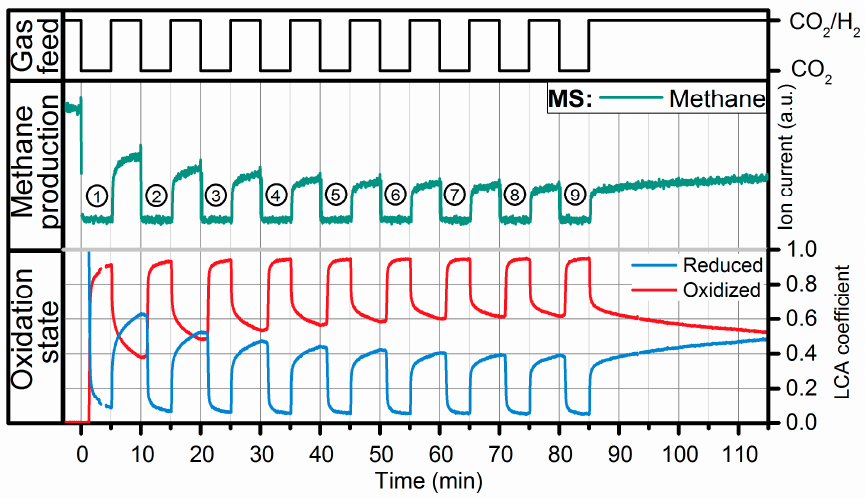
Figure 7. Methanation of CO 2 during dynamic operation switching every 300 s between methanation conditions (H 2 /CO 2 = 4) and CO 2 at constant WHSV of 12,000 mL CO2 /(g cat ·h) and GHSV of 71,700 h − 1 . The figure shows the valve signal in the upper part (black), the CH 4 signal of the MS ( m / z 15) in the middle part (green) and the fraction of reduced (blue) and oxidized (red) Ni from LCA of the XANES spectra. The numbers in cycles count the H 2 dropouts.